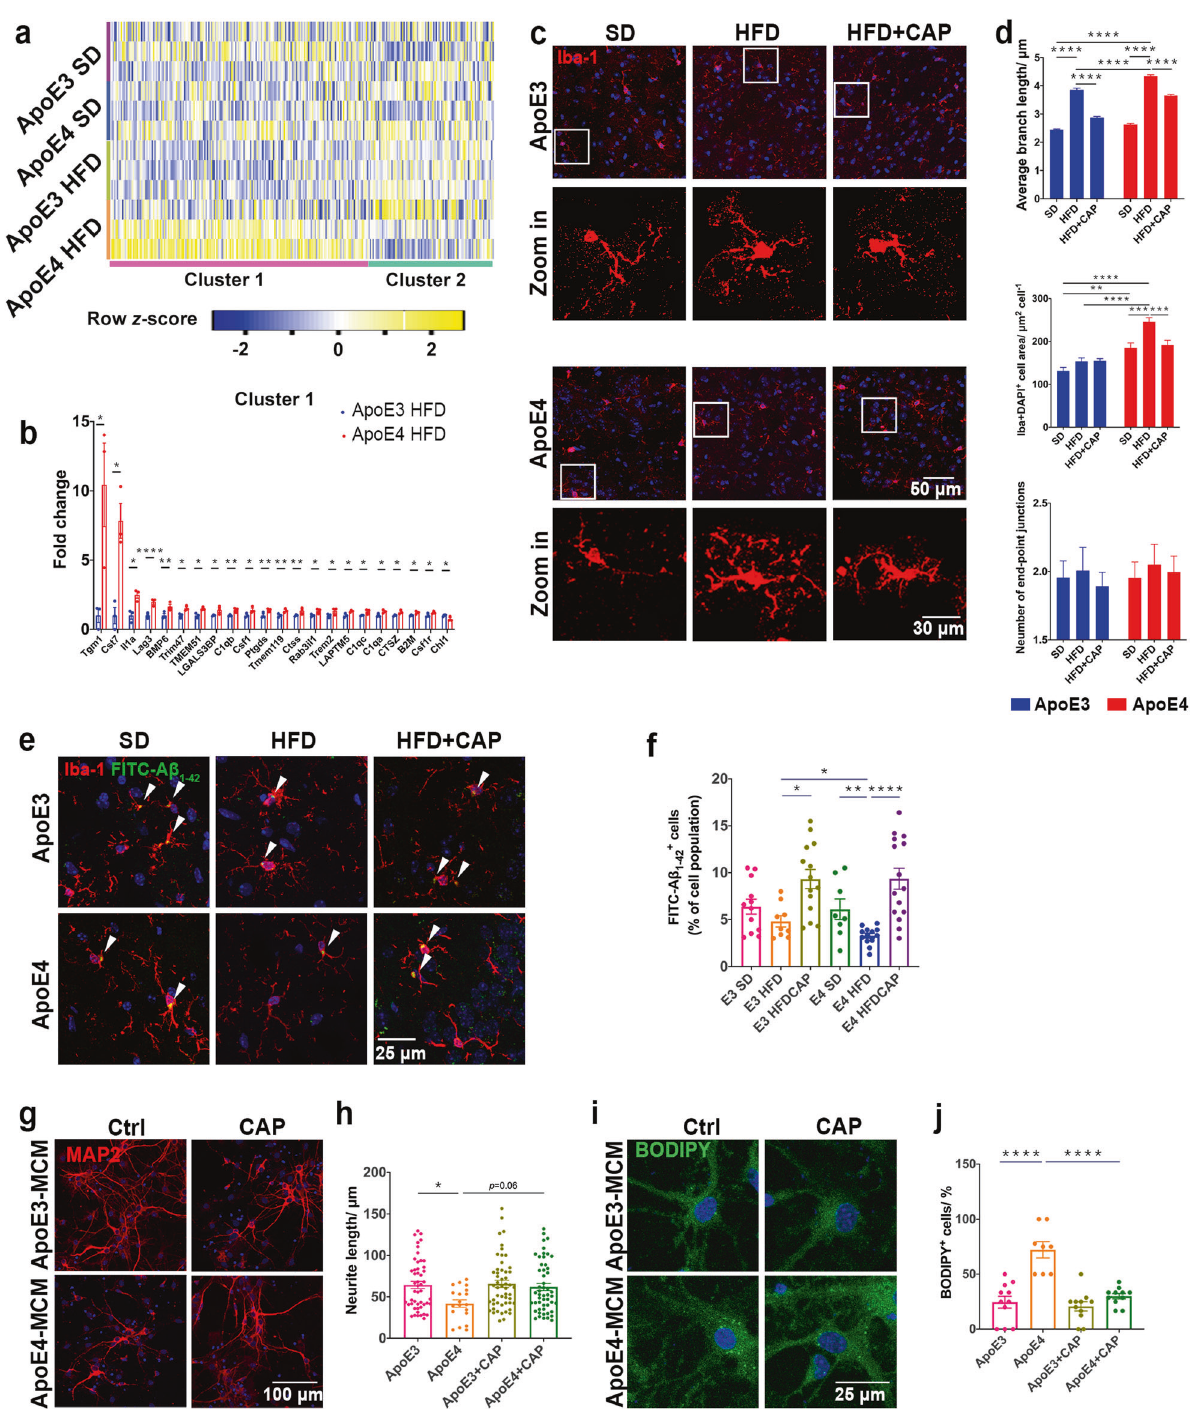
Fig. 6 TRPV1 activation attenuated microgliosis and microglial lipid accumulation in ApoE4 HFD mice. a Heatmap showing gene expression pro fi les correlated with microglial proin fl ammatory reactions (Cluster 1) and normal functions (Cluster 2). b Differentially expressed Cluster 1 genes between HFD-fed ApoE3 and ApoE4 mice from the heatmap ( a ). c Immuno fl uorescent images of Iba-1 + cells of ApoE3 and ApoE4 mice in the cerebral cortex (upper panel) and ampli fi ed single Iba-1 + cells (lower panel). d Morphological analyses of Iba-1 + cells from the immuno fl uorescence micrographs ( c ). Blue bars indicate ApoE3 mice, and red bars indicate ApoE4 mice. e Representative immuno fl uorescent images of FITC-labeled A β 1-42 and Iba-1 + cells of ApoE3 and ApoE4 mice. f Quanti fi cation of A β 1 – 42 uptake in Iba-1 + cells. g , h Representative immuno fl uorescent images and quanti fi cation of MAP2 in primary cortical neurons. i , j Representative immuno fl uorescent images and quanti fi cation of BODIPY + puncta in primary neurons. n = 3 mice per group. Statistical tests: two-sided Student ’ s t test ( b ), two-way ANOVA followed by Sidak ’ s multiple comparison test ( d ), one-way ANOVA followed by Tukey ’ s post hoc test ( f , h , j ). Data represent the mean ± s.e.m. * p < 0.05, ** p < 0.01, *** p < 0.001, **** p < 0.0001. Scale bars, 50 μ m ( c upper panel), 20 μ m ( c lower panel), 25 μ m ( e